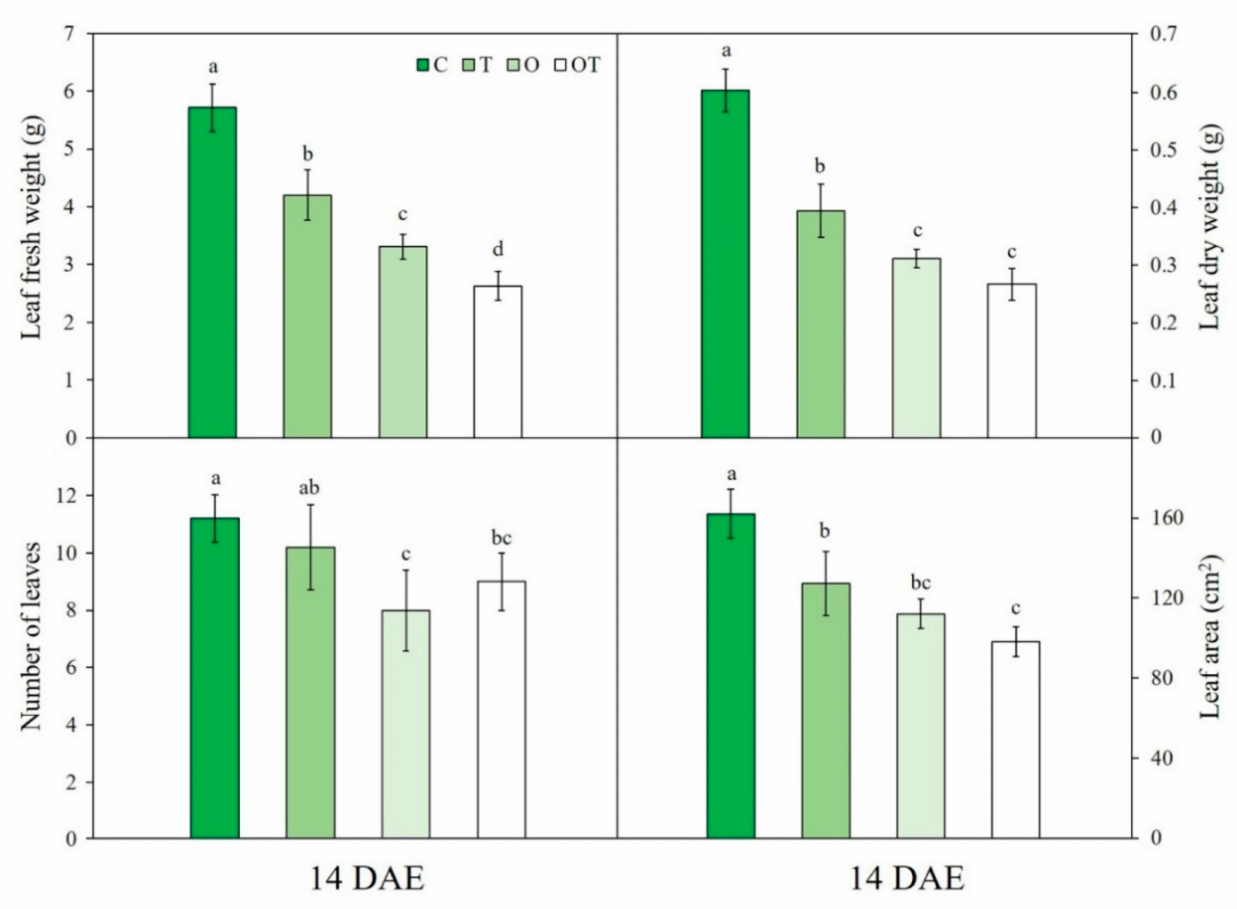
Figure 9. Leaf fresh weight, dry weight, number, and area of Brassica juncea L. under different ambient and supraoptimal temperatures and O 3 concentration at 14 DAE. Data are plotted as mean ± SD ( n = 5). Different letters indicate significant differences among treatments at p < 0.05 according to Tukey’s honestly significant difference test. C: ambient O 3 + optimal temperature; T: ambient O 3 + supraoptimal temperature; O: elevated O 3 + optimal temperature; OT: elevated O 3 + supraoptimal temperature; DAE: days after the beginning of